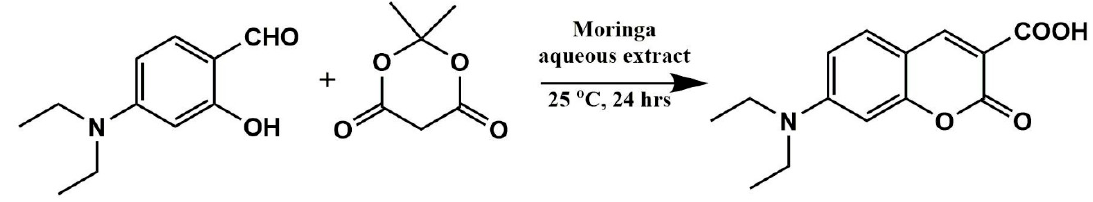
Figure 3. Aqueous Moringa extract-mediated synthesis of the fluorescent probe 7-DCCA.